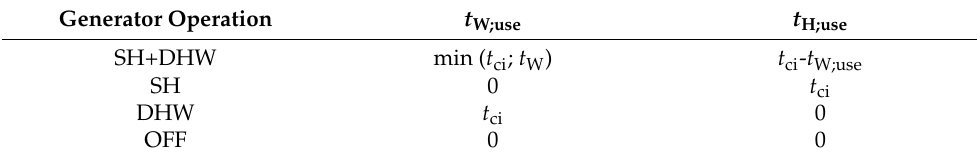
Table 1. Usage period calculation t X;use